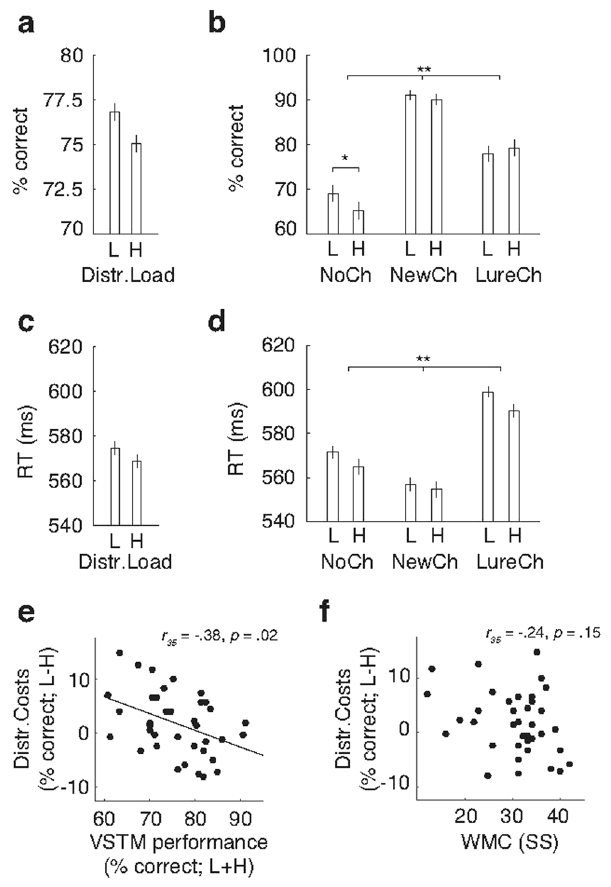
Figure 2. Behavioral performance on the change-detection task. ( a ) Accuracy of performance shown separately for low and high distractor load trials (averaged across trial type). ( b ) Accuracy of performance shown separately per trial type (no change; new change; lure change) and condition (low vs. high distractor load). Performance accuracy was lowest on no-change trials. Only in these trials, impaired performance was observed in high compared to low distractor load trials. ( c ) Response times on the task shown separately for low and high distractor load trials (averaged across trial type). ( d ) Response times per trial type (no change; new change; lure change) and condition (low vs. high distractor load). Response times differed across trial types, but were not affected by distractor load. ( e ) VSTM capacity (average performance on low and high distractor load trials) negatively predicted the effect of distractor load on VSTM performance (performance on high minus low distractor load trials), such that a high distractor load generally impaired performance more in low vs. high capacity individuals. ( f ) WMC as measured on the symmetry span task was not significantly related to the effect of distractors on performance. Error bars represent the standard error of the